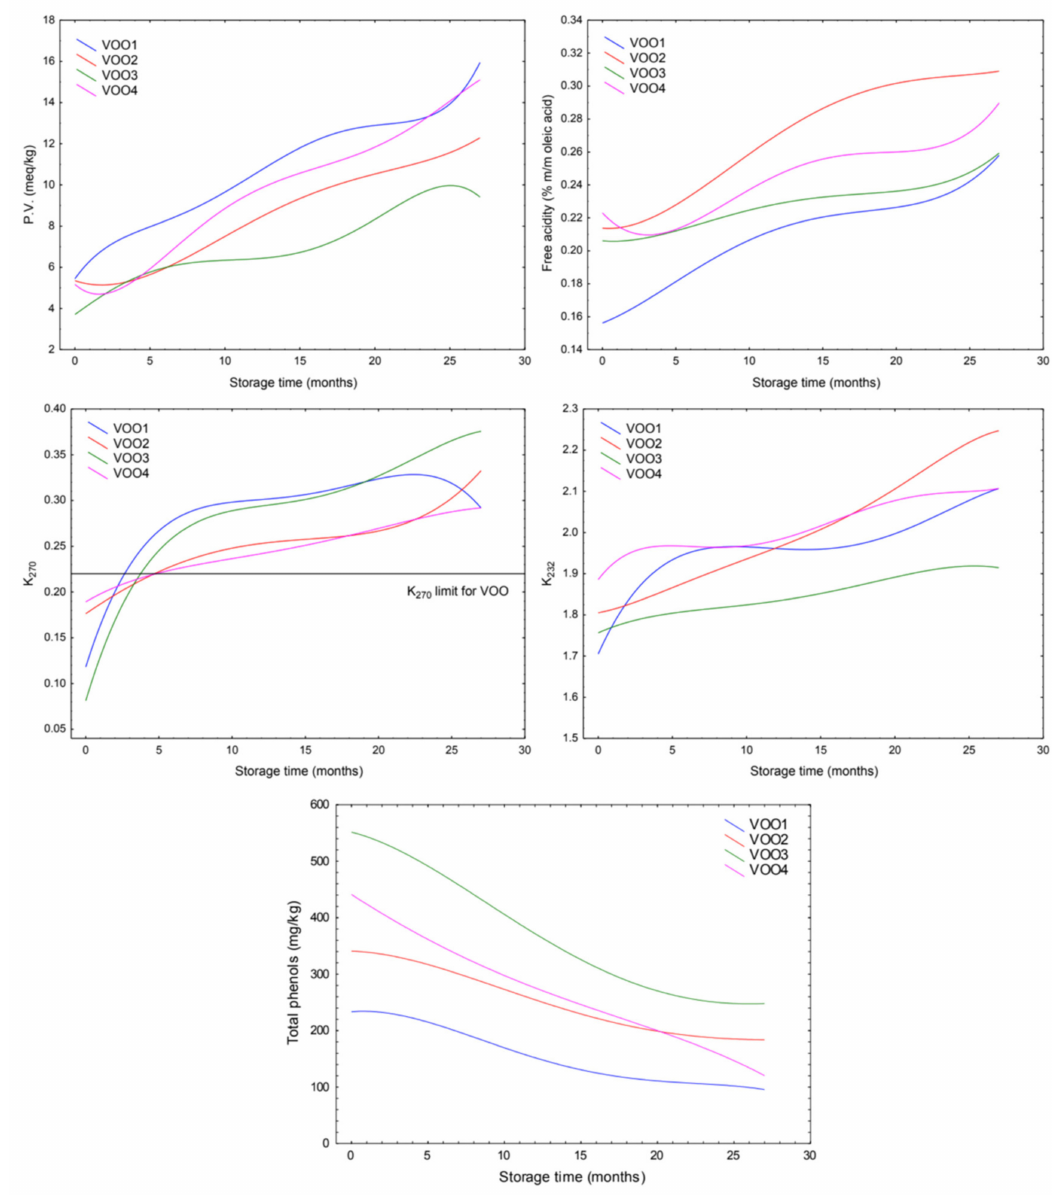
Figure 1. Time-course plots of peroxide value (PV), free acidity (FFA), ultraviolet absorbance at 270 nm (K 270 ) and 232 nm (K 232 ) and total phenols concentration per each virgin olive oil (VOO) (polynomial fitting). According to [13]: Limits for extra virgin olive oil (EVOO): PV ≤ 20 meq O 2 / kg, FFA ≤ 0.8%, K 270 ≤ 0.22, K 232 ≤ 2.50. Limits for virgin olive oil (VOO): PV ≤ 20 meq O 2 / kg, FFA ≤ 2.0%, K 270 ≤ 0.25, K 232 ≤